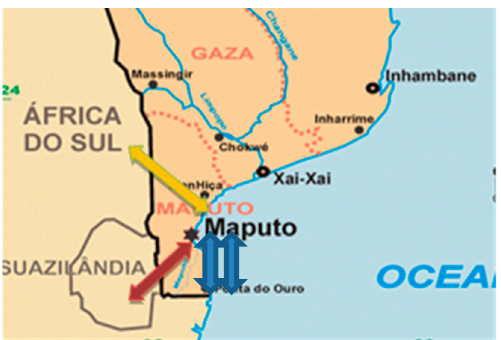
Figure 1. Map of southern Mozambique with the borders of Ressano Garcia, Namaacha, Goba, and Ponta de Ouro.